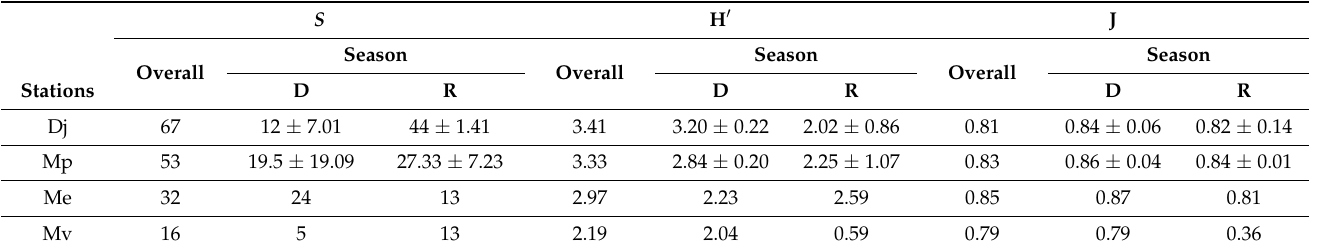
Table 4. Variations of the values of the species richness (S), Shannon diversity ( H (cid:48) ) and Pielou ( J ) indices in the communities of the different park rivers (Dj = Djim River; Mp = Mpem River; Me = Mey River; Mv = Mvouring River) and seasons (D = dry season; R = rainy season). S H (cid:48) J Overall Overall